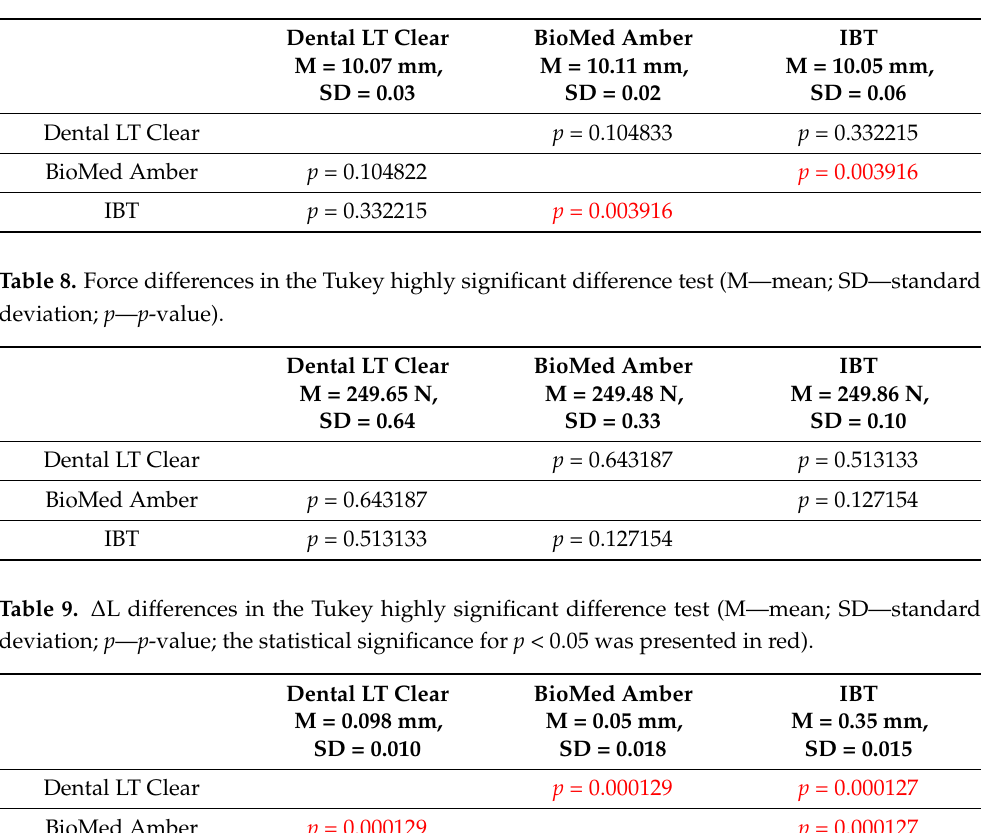
Table 7. Mean width differences in the Tukey highly significant difference test (M—mean; SD— standard deviation; p — p -value; the statistical significance for p < 0.05 was presented in red).